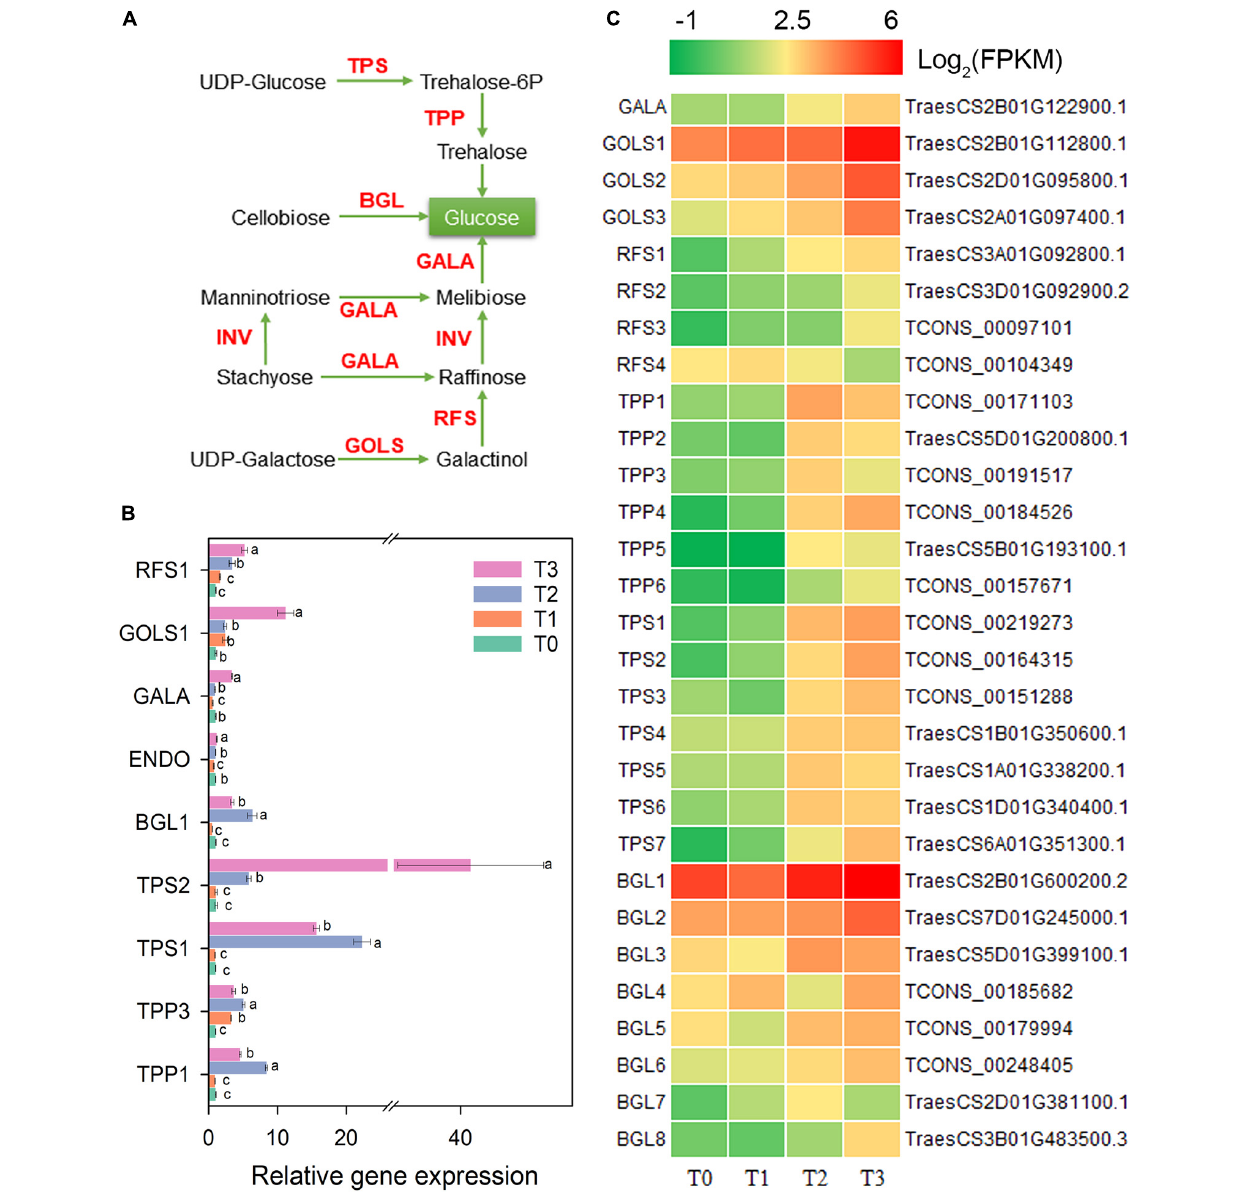
phosphofructokinase (PFK), fructose-1,6-bisphosphatase (FBP), fructose-bisphosphate aldolase (ALDO), glyceraldehyde-3- phosphate dehydrogenase (GAPDH), phosphoglycerate kinase (PGK), pyruvate-phosphate dikinase (PPDK), and pyruvate decarboxylase (PDC) was significantly increased ( Figure 7C